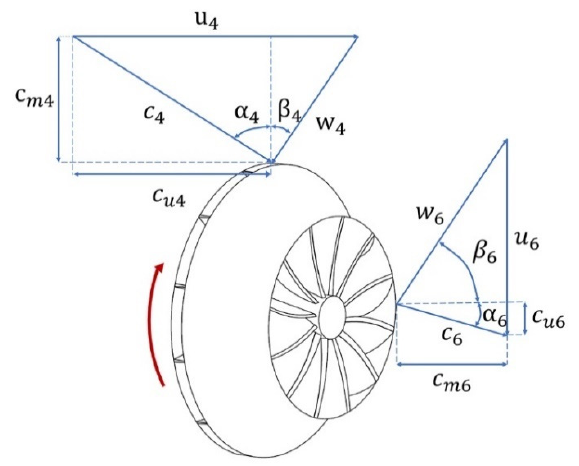
Figure 3. The velocity triangles of the radial turbine rotor inlet and outlet.